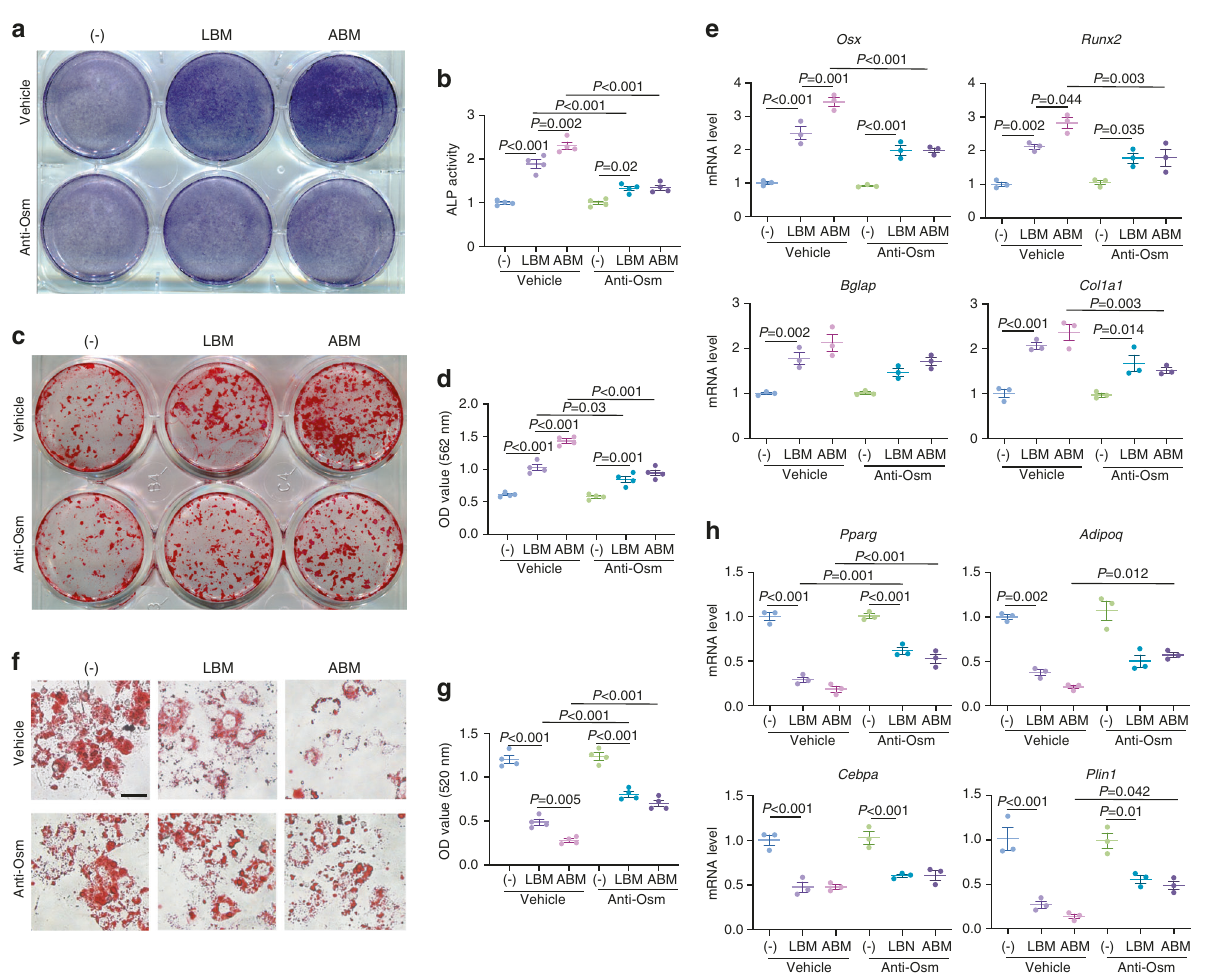
Fig. 7 The regulatory effect of macrophages on MSCs is Osm-dependent. a , b ALP staining and ALP activity quantitative analyses of MSCs after Osm neutralization. c , d ARS staining and quantitative analyses of MSCs after Osm neutralization. e RT-qPCR for the osteogenesis-related genes after Osm neutralization. f , g Oil red O staining and quantitative analyses of MSCs after Osm neutralization. Scale bar, 50 μ m. h RT-qPCR for the adipogenesis-related genes after Osm MATERIALS AND METHODS Osm is a cytokine secreted by monocytes/macrophages, and has Single-cell RNA sequencing important regulatory role on bone homeostasis. 37 – 40 Osm receptor knockout mice exhibit decreased bone remodeling activity. 34 In a tibial defect model, Osm knockout led to a decrease in osteoblasts number and delayed bone healing. 41 Moreover, Osm inhibited the adipogenic differentiation of MSCs. 42 Osm knockout mice show increased adipose tissue accumulation in bone marrow with age. 43